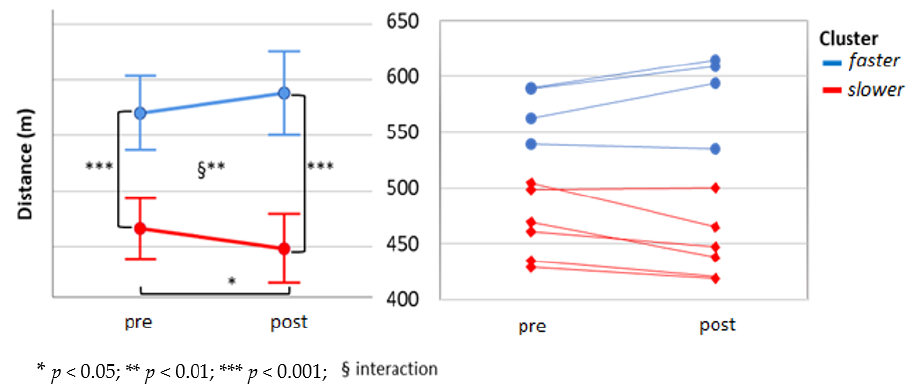
Figure 6. The 6 minute walk test. Box plots of pre- and post-intervention distances covered during the 6MWT by the entire group.